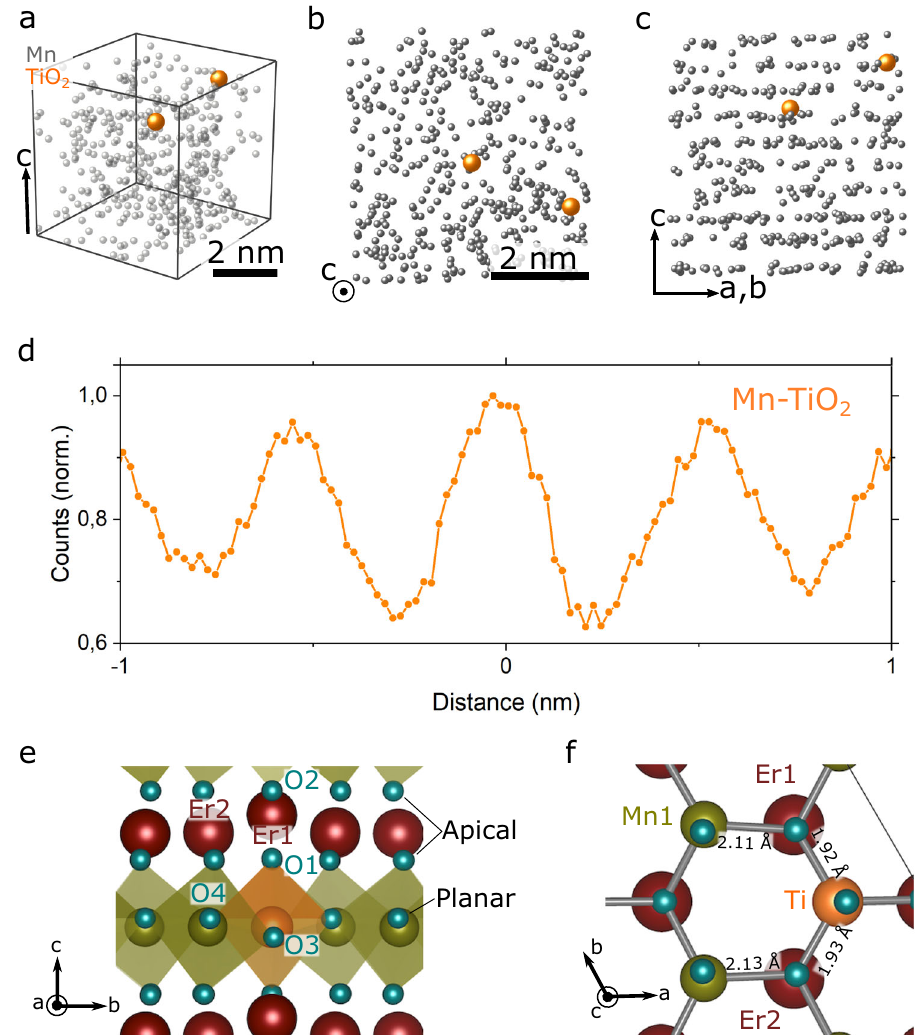
Fig. 3 | 3D Imaging of individual Ti dopant atoms in Er(Mn,Ti)O 3 . a APT recon- struction from a region in the pole presenting the Mn (semi-transparent gray) atoms and Ti (orange) atoms (TiO 2 + species). b Same volume asshown in a viewed alongthe c -axisand c perpendiculartothe c -axissothatthelayeredstructureofthe Mn atoms is visible. The data indicate that the Ti atoms are located within the Mn